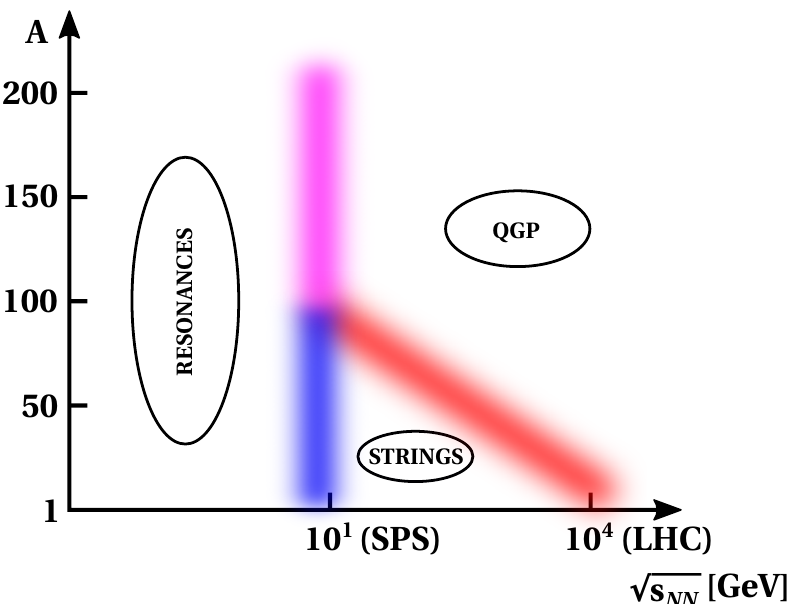
Figure 4. Schematic diagram of high-energy nuclear collisions outlined in colliding nuclei mass √ s NN variables. Domains in which hadron production is dominated number, A, and collision energy, by the creation, evolution and decay of resonances, strings and quark–gluon plasma are indicated as resonances , strings and QGP , respectively, while thick coloured lines show the changeover regions between the